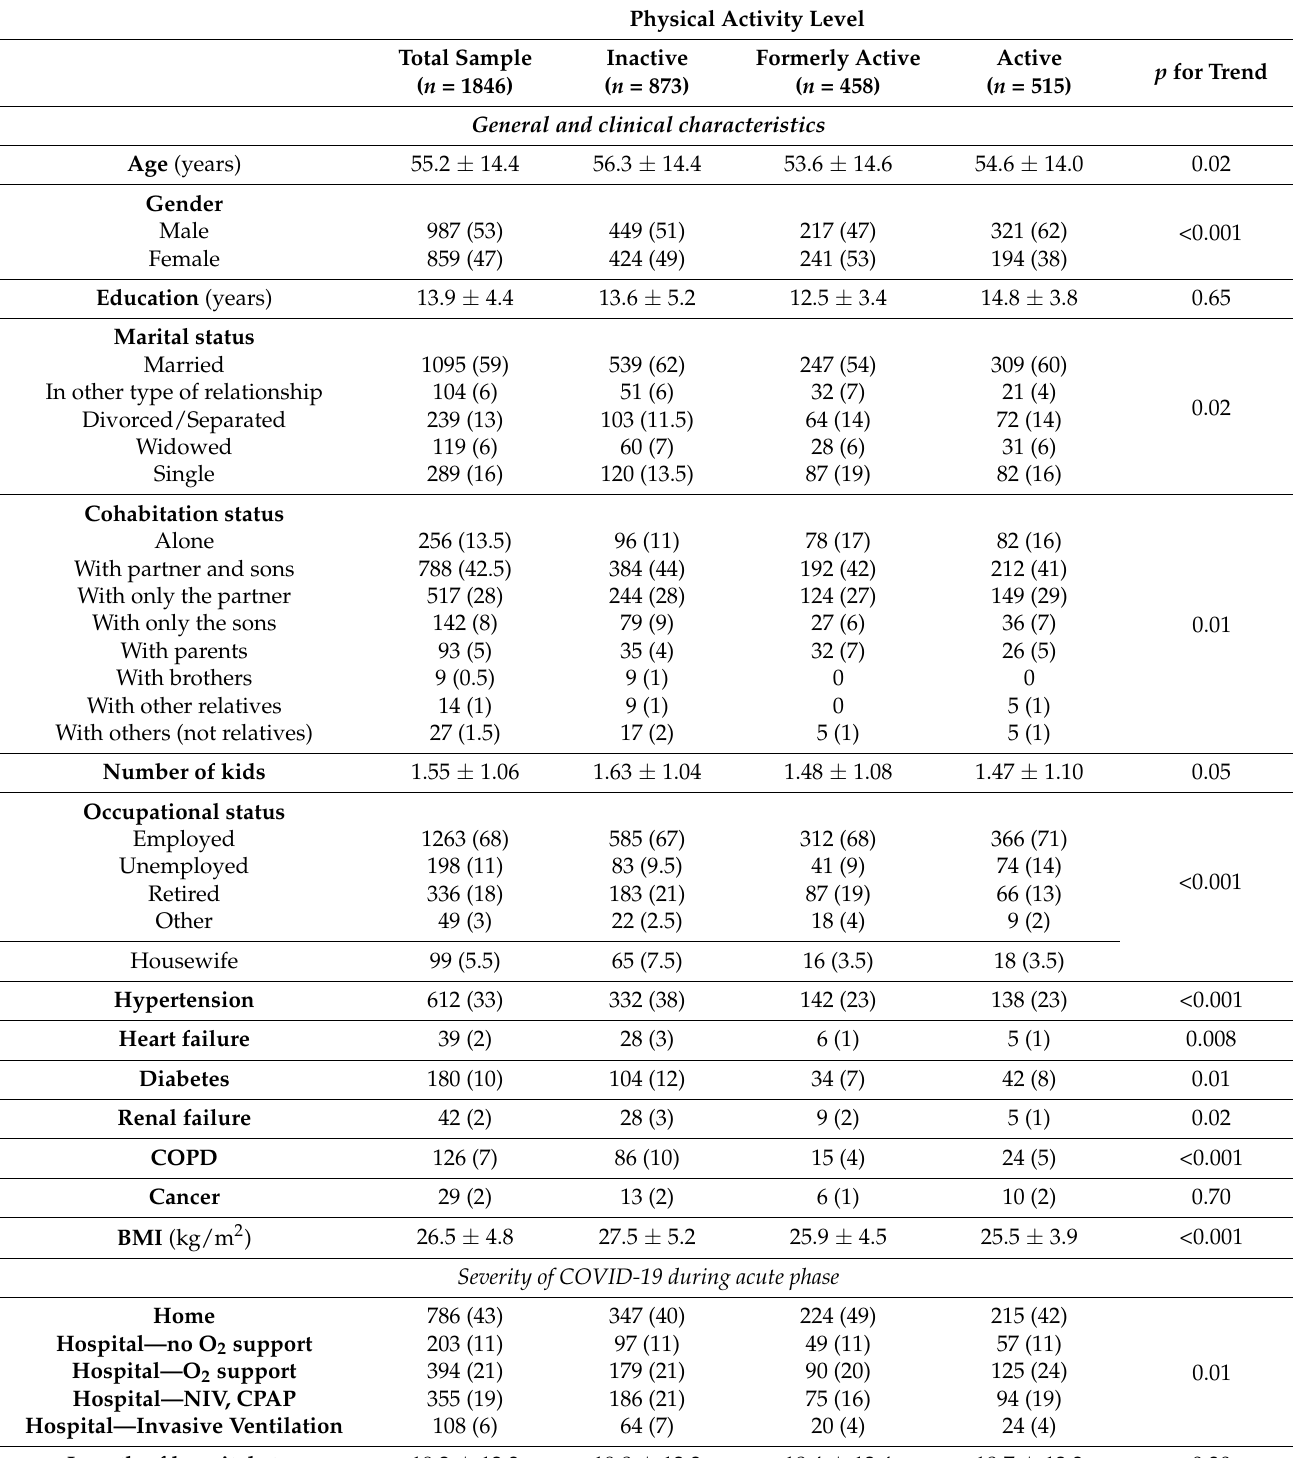
Table 1. Characteristics of study population according to physical activity level